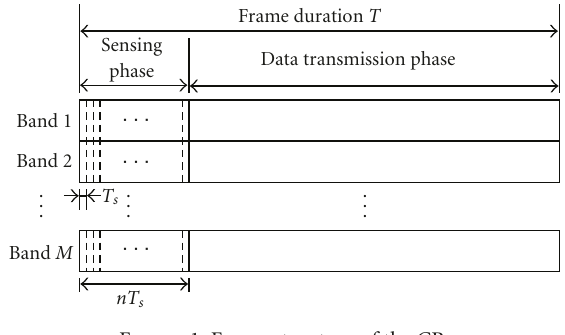
Figure 1: Frame structure of the